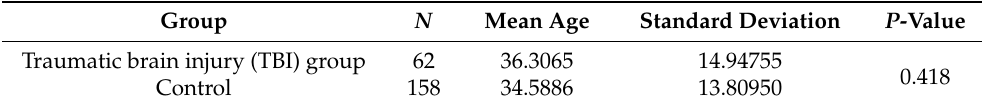
Table 1. Difference between mean and standard deviation of age of studied personnel according to the groups.